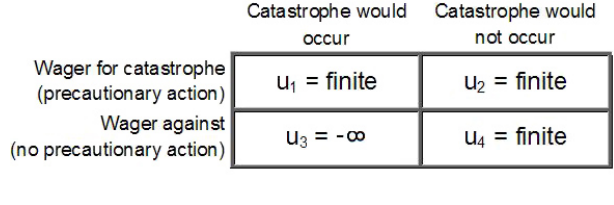
Fig. 2 . Payoff matrix for an environmental analogue of Pascal’s wager. It is assumed that an ecological catastrophe, should it occur, would have an infinite negative utility. However, precautionary action would avert this catastrophic outcome, leading to a finite